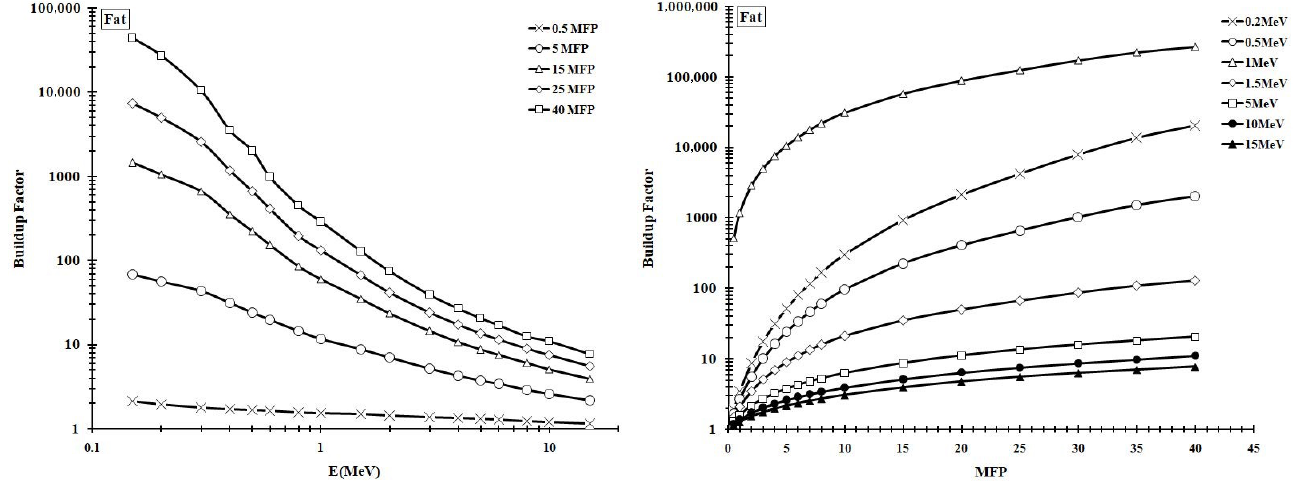
Figure 8. Buildup factor for fat tissue as a function of: ( left side ) photon energy for fixed depths between 0.5 and 40 mfp and ( right side ) depth for fixed photon energies between 0.15 and 15